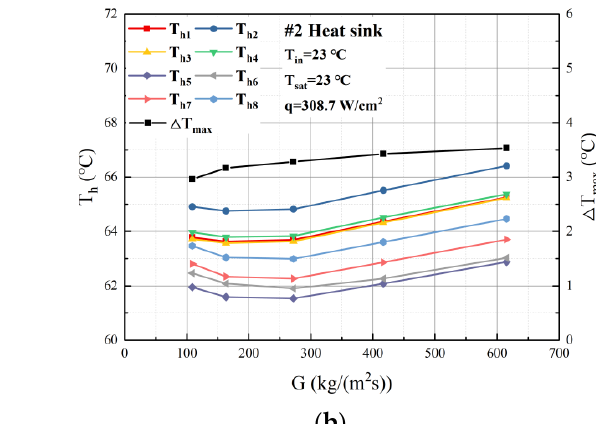
Figure 7. Heat dissipation performance of heat sink at different mass fluxes. ( a ) #1 heat sink. ( b ) #2 heat sink.